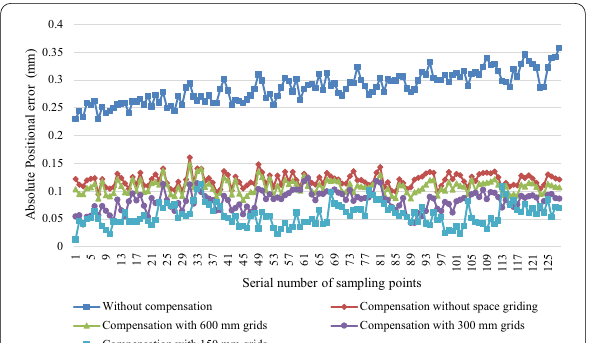
Figure 18 Simulation environment and machining trajectory